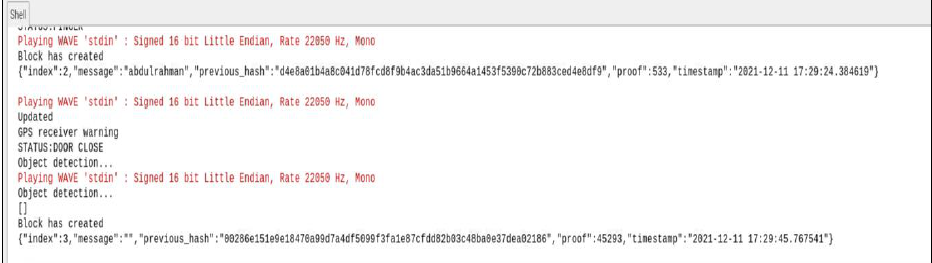
Figure 7. Generating blocks using the private blockchain technology.